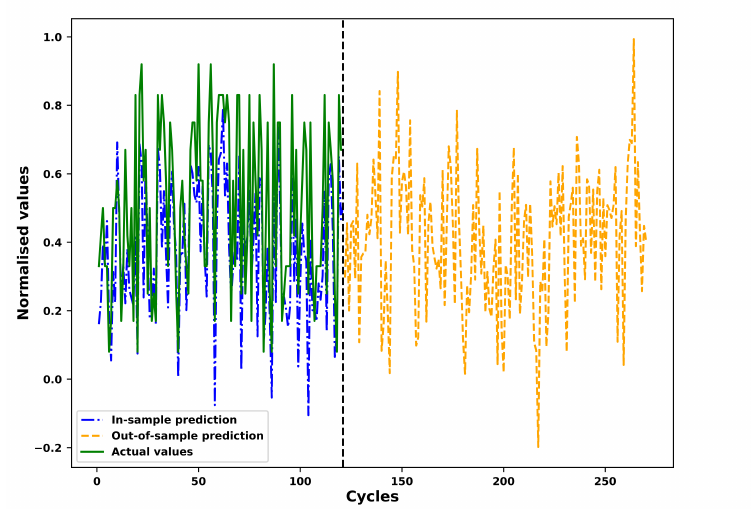
Figure 10. Prediction of the second operational conditions of the unit 37 in FD001 test sets based on the FGM(1, 1) and ARIMA/ARMA